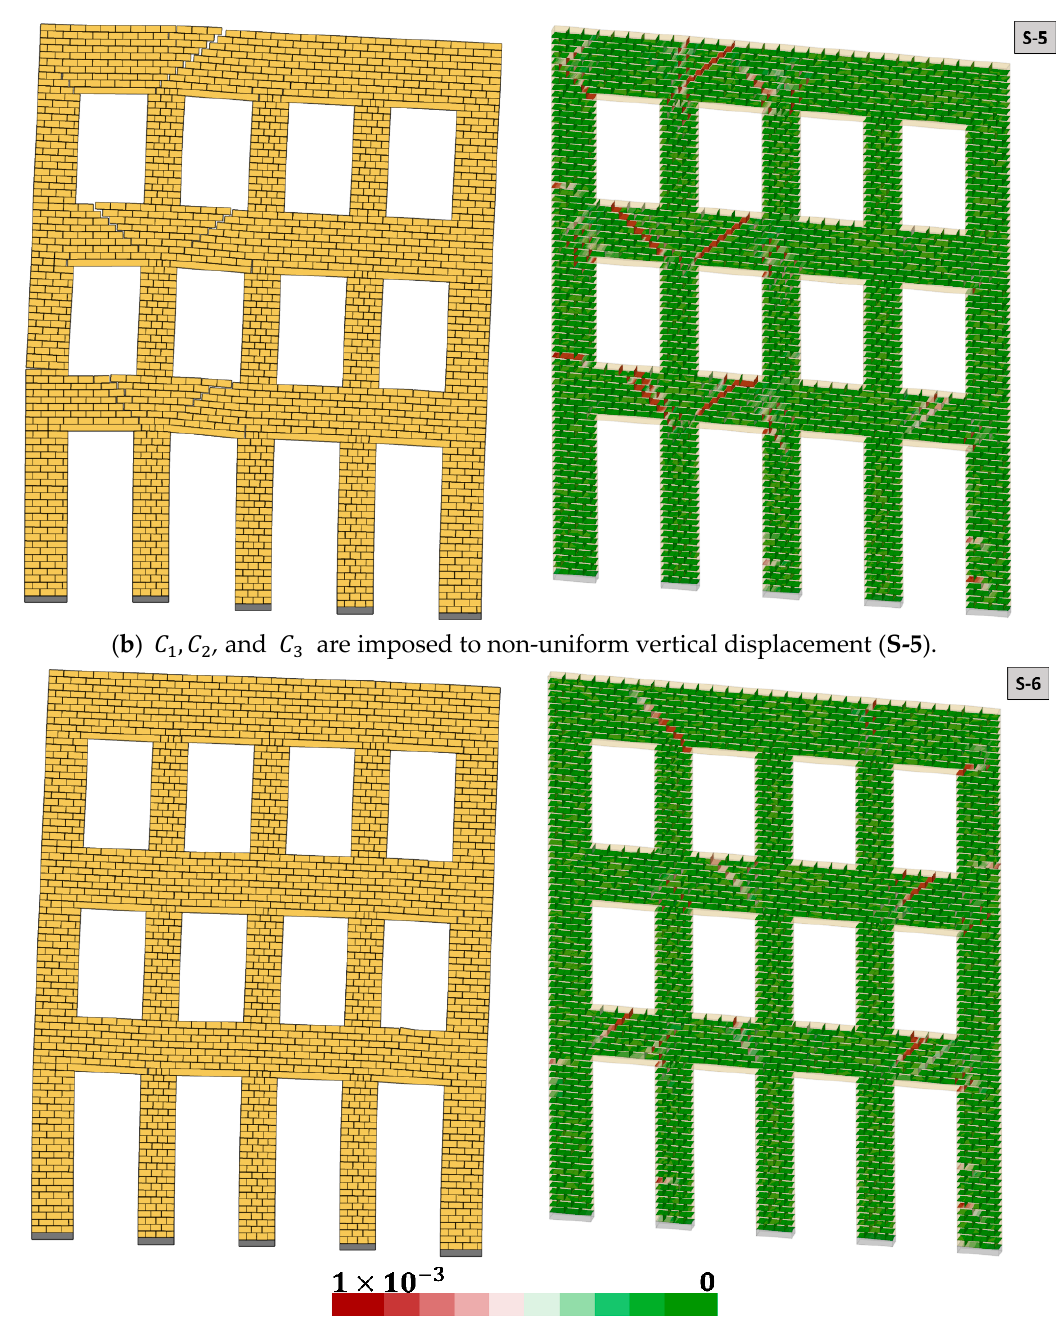
Figure 8. Non ‐ uniform support settlement D ‐ RBA: Crack pattern ( left ) and joint opening ( right , in meters) when ∆𝑢 (cid:3040)(cid:3028)(cid:3051) Figure 8. Non-uniform support settlement D-RBA: Crack pattern ( left ) and joint opening ( right , in meters) when ∆ u = 0.05 m. max = 0.05